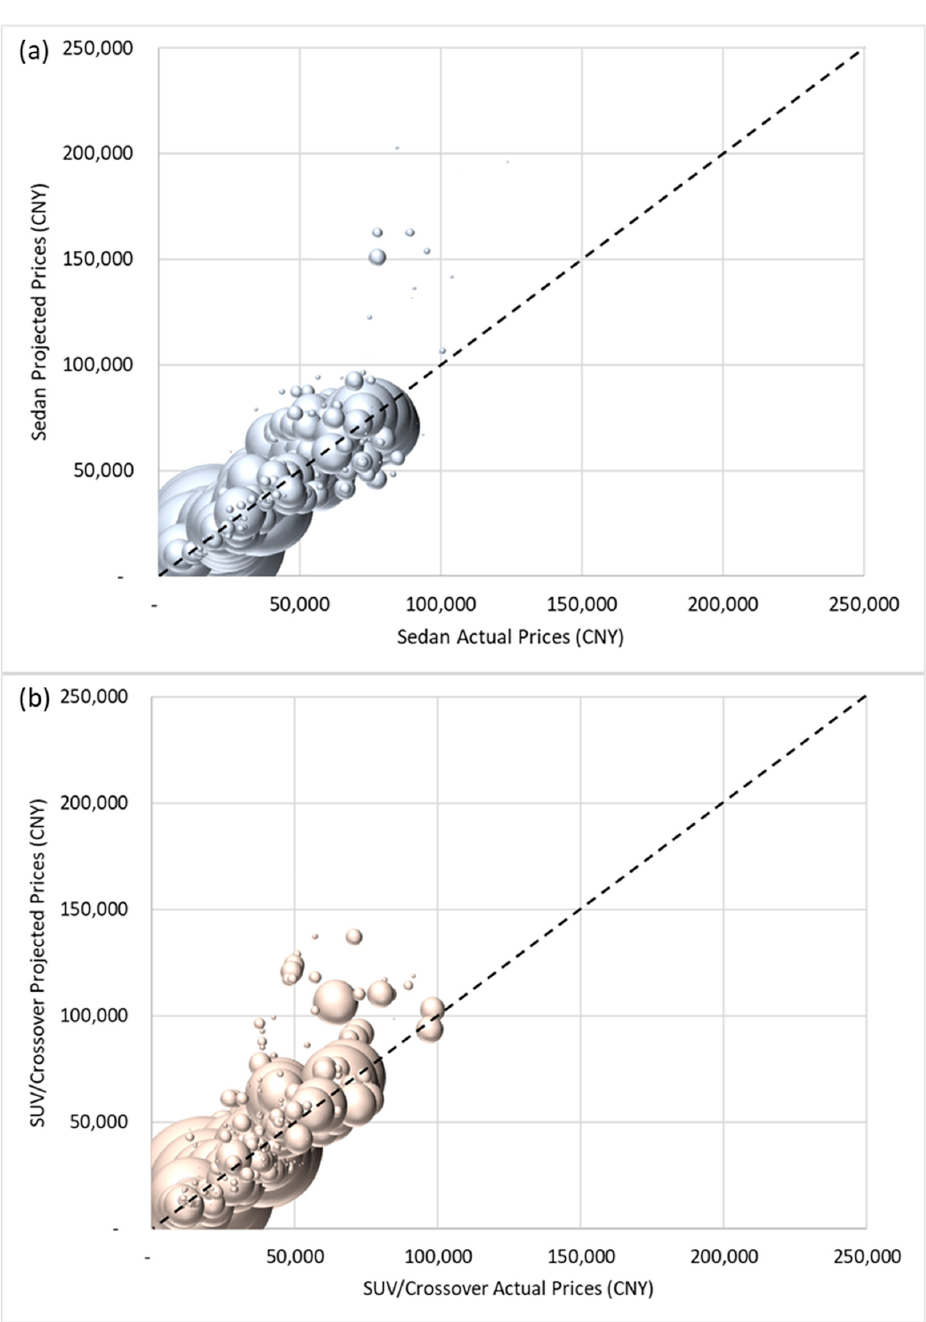
Figure 5. Comparison between actual and projected vehicle prices in the training dataset: ( a ) sedan; and ( b ) SUV/crossover. (Bubble size shows the sales of vehicle models). and ( b ) SUV / crossover. (Bubble size shows the sales of vehicle